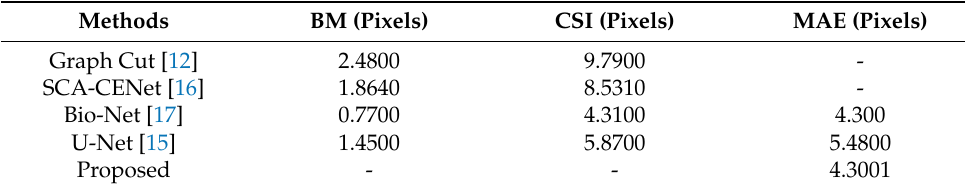
Table 4. Comparison with segmentation based